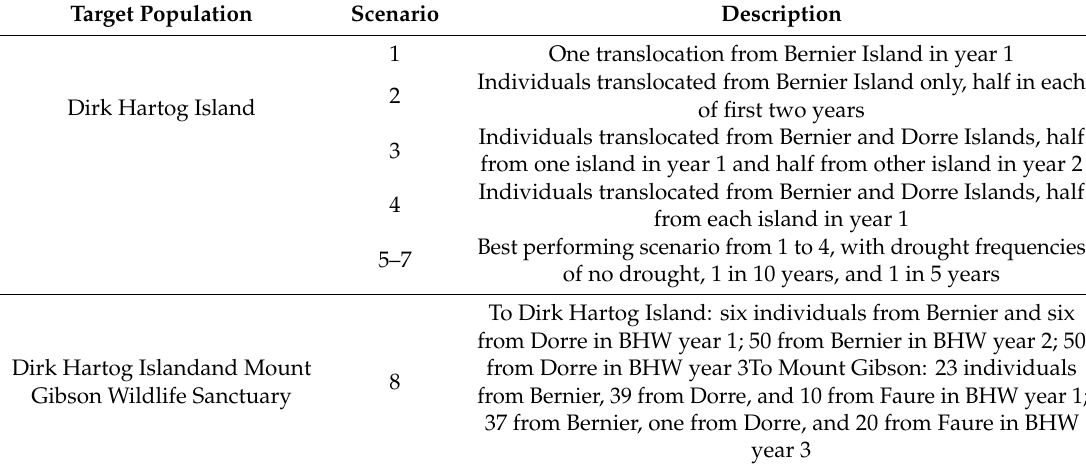
Table 2. Hypothetical and case study translocation scenarios * examined using population viability